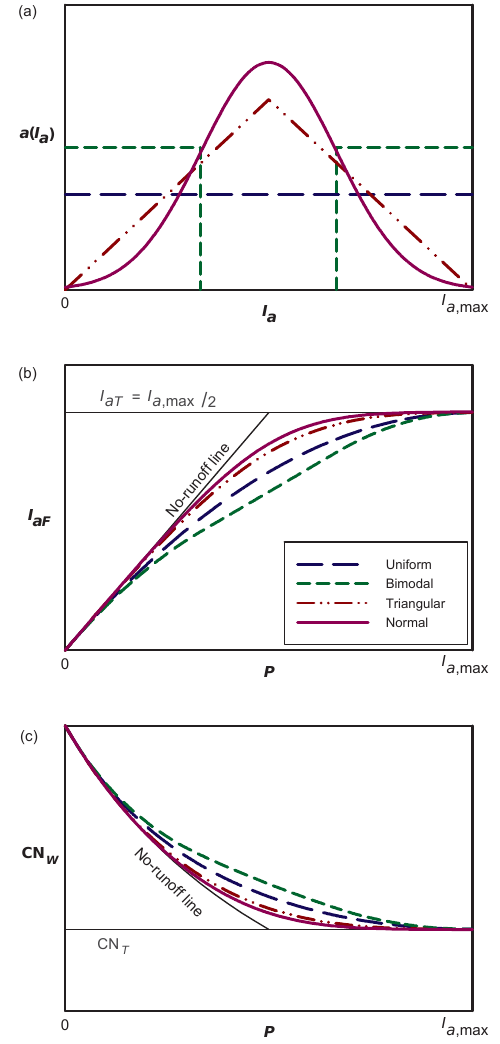
Figure 8. (a) Various symmetrical distributions of I a with the same minimum (zero), mean ( I a , max / 2), and maximum ( I a , max ); (b) the corresponding I aF curves calculated using Eq. (16); (c) the corre- sponding CN W curves calculated using Eq.